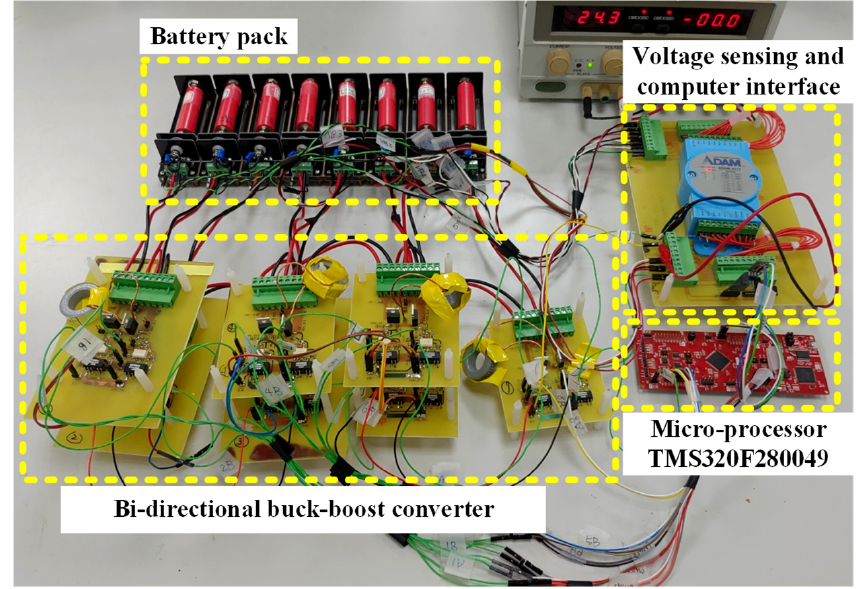
Figure 8. Experimental platform of the equalizer system.